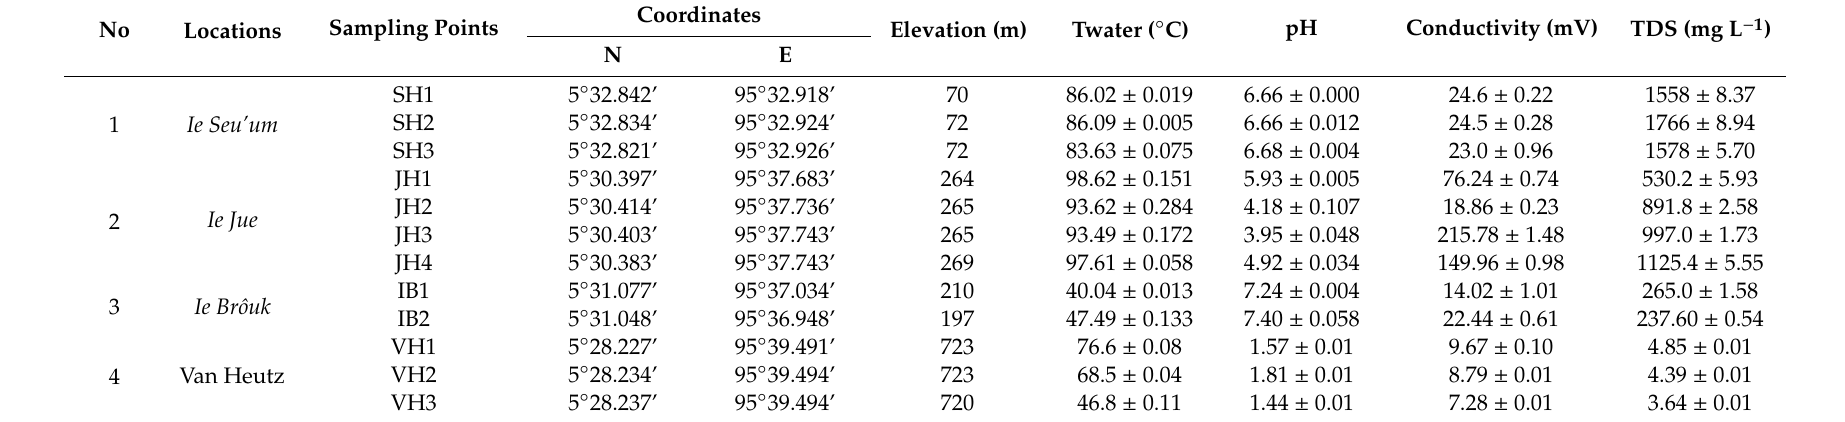
Table 4. Characteristics of surface manifestation of the north zone, Seulawah Agam